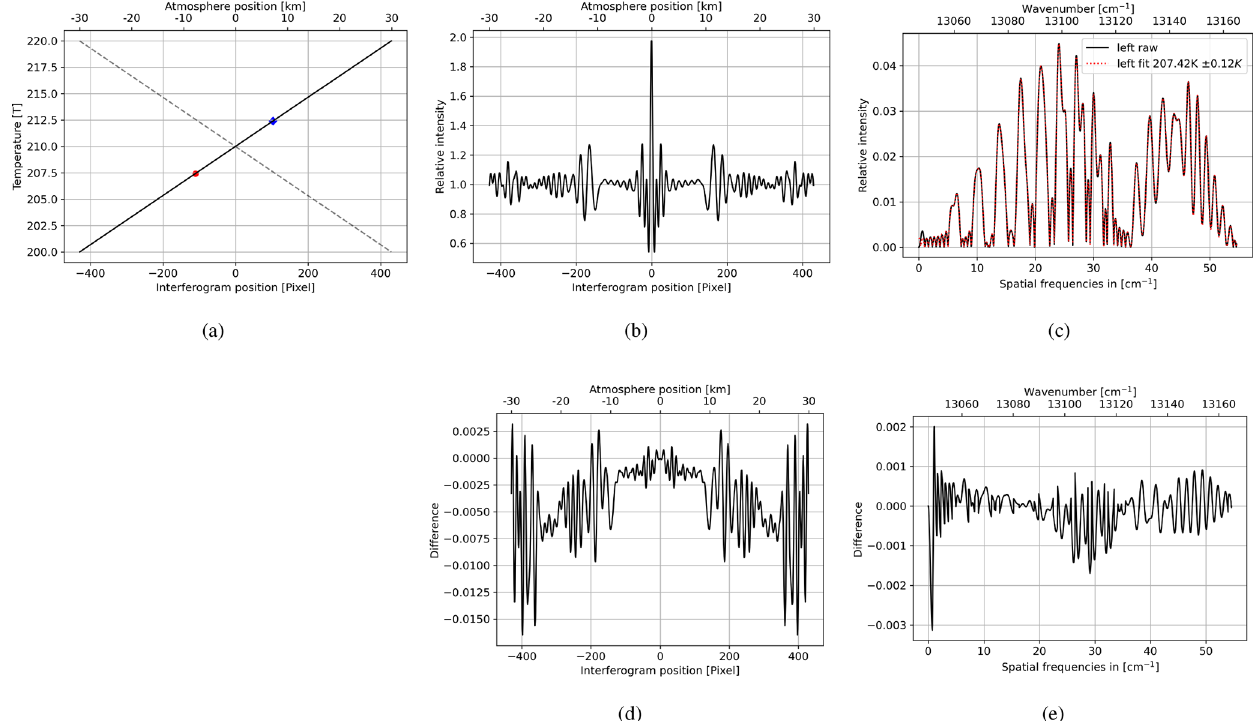
Figure 7. Simulation of interferogram split assuming a linear temperature gradient. Panel (a) shows the temperature gradient from 200 to 220K across the horizontal field (solid line) with each side symmetrically extended around the center (dashed lines); the red circle and the blue diamond indicate the location of the retrieved temperature for the left and right hand side. Panel (b) shows the left symmetrically extended interferogram. Panel (c) shows the temperature retrieval of (b) . Panel (d) shows the difference between the left and right symmetrically extended interferogram. Panel (e) shows the difference between the left and right symmetrically extended raw